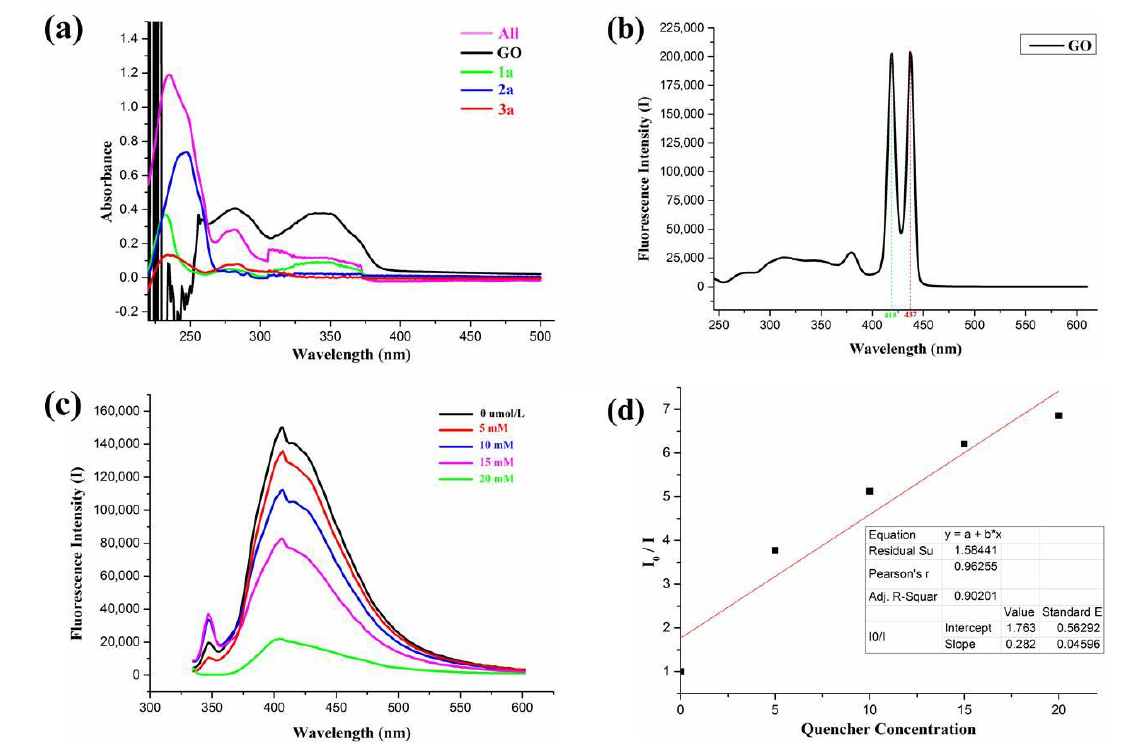
Figure 1. Ultraviolet–visible absorption and Stern–Volmer quenching experiments. ( a ) UV–visible spectra of GO and different substrates. ( b ) The fluorescence excitation spectrum of GO. ( c ) The Molecules 2022 , 27 , x FOR PEER REVIEW 7 of fluorescence emission spectra of GO with different concentration of added quencher excited at 437 nm. ( d ) GO emission quenching by linear quenching on different concentrations of substrates.